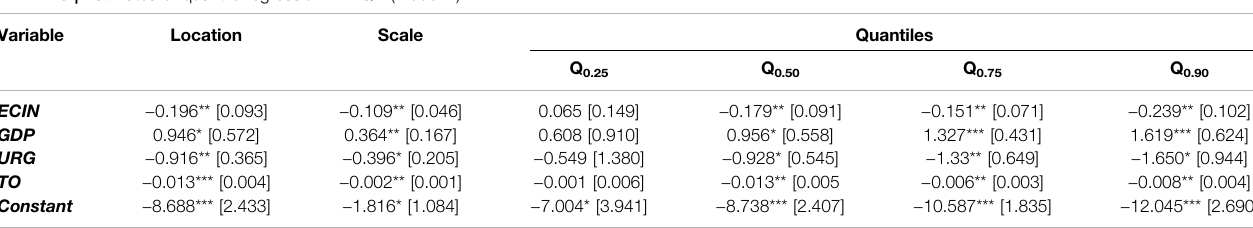
TABLE 8 | Estimates of quantile regression – MMQR (Model 2).